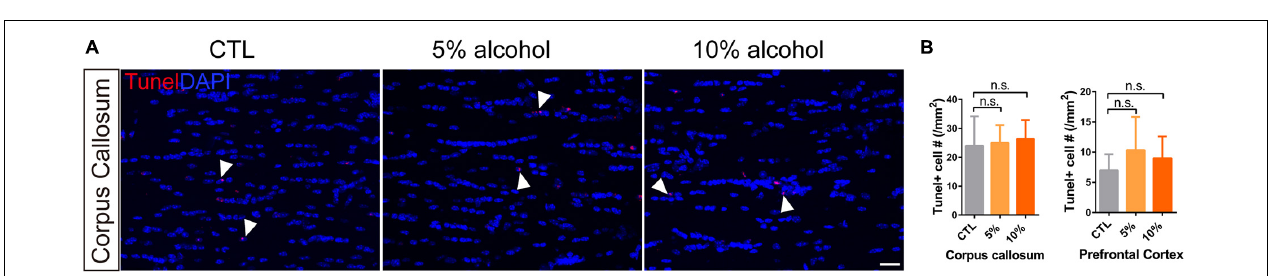
FIGURE 4 | Mature OLs generation is reduced by alcohol drinking in adult mice. (A) Immunostaining of CC1 in the cortex showing the newly generated mature OLs (CC1 + mGFP + ) (arrowheads). Scale bar 50 µ m. The dotted white box was magnified in the right panel. (B) Quantification of CC1 + mGFP + new OLs in the corpus callosum and prefrontal cortex (*** p < 0.001, n = 7).